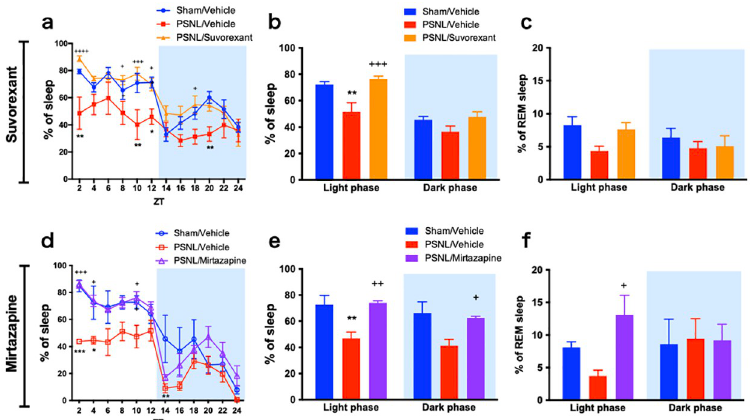
Fig 3. Suvorexant and mirtazapine improved the amount of sleep time in PSNL mice. The time changes of the sleep percentage are shown for every 2 h (a, d) and every 12 h (b, e). The proportions of REM sleep per total sleep were shown (c, f). Data are expressed as means ± SEMs (sham-vehicle, n = 5–6; PSNL-vehicle, n = 5; PSNL-suvorexant, n = 6; PSNL-mirtazapine, n = 5). � P < 0.05, �� P < 0.01, and ��� P < 0.001 compared between each sham-vehicle and PSNL-vehicle group, and + P < 0.05, ++ P < 0.01, +++ P < 0.001, and ++++ P < 0.0001 compared between each PSNL- vehicle and PSNL-drug (suvorexant or mirtazapine) group by two-way ANOVA with Bonferroni